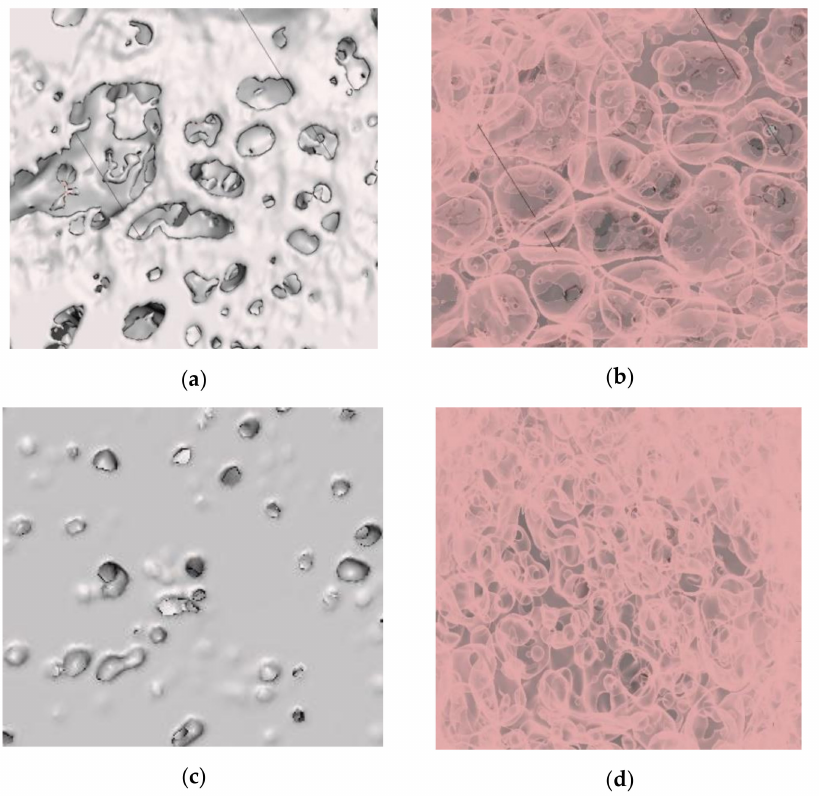
Figure 10. Cropped 3D model. Top view of foam, and the distribution of pores inside the 3D model (identical view), with 72.5% porosity ( a , b ) and with 39.9% porosity ( c , d